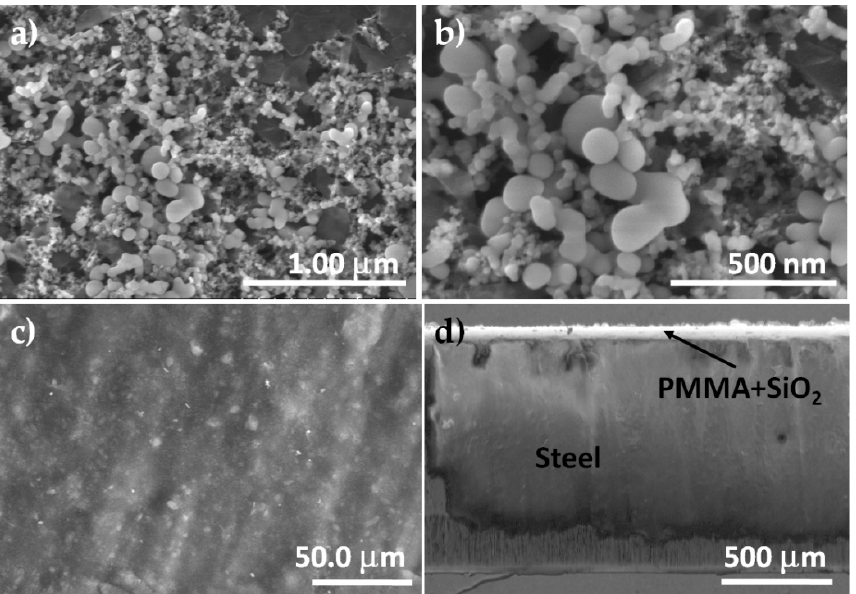
Figure 1. Scanning electron microscopy (SEM) micrographs of the morphology of: ( a ) and ( b ) commercial SiO 2 particles, ( c ) poly (methyl methacrylate) (PMMA)-SiO 2 coating, and ( d ) cross-section of the PMMA + SiO 2 deposited on the stainless steel AISI 304.